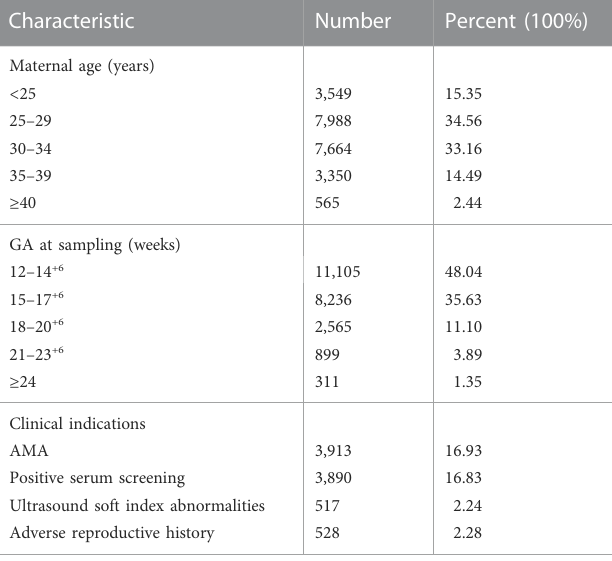
TABLE 1 Demographics and clinical characteristics of